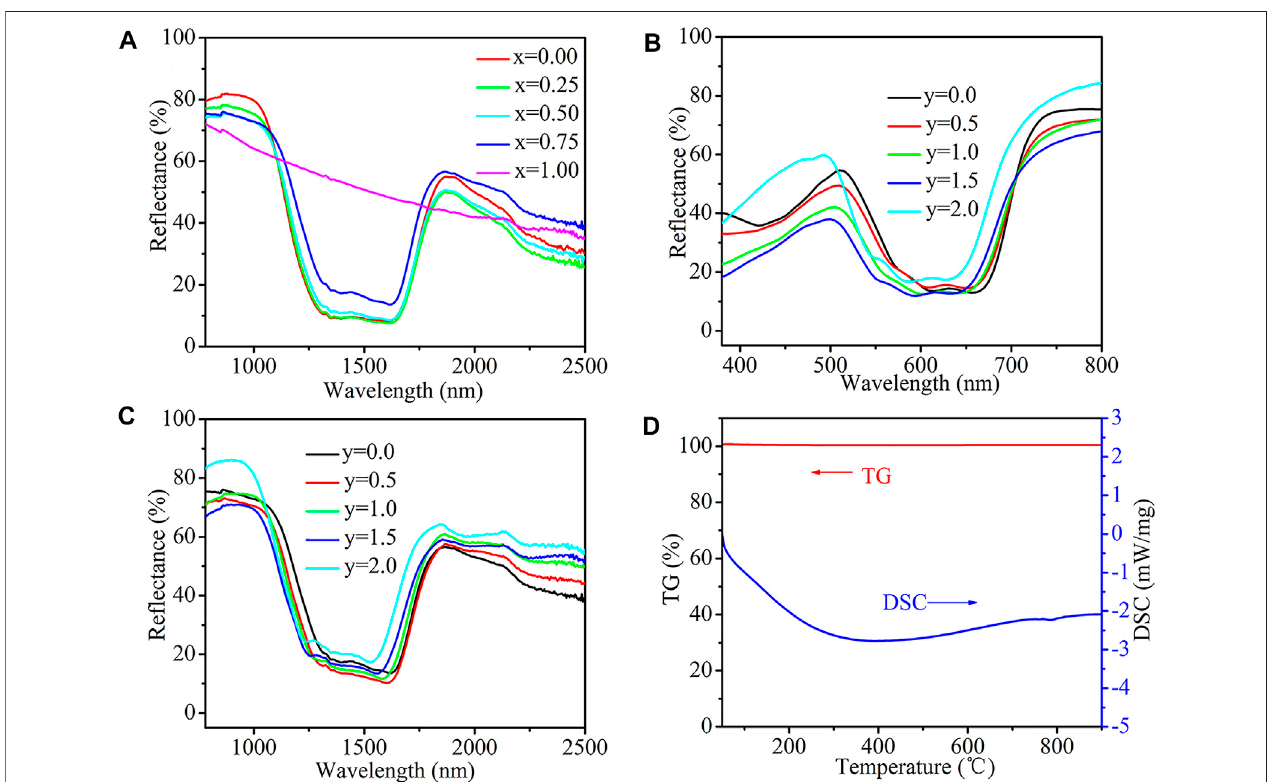
FIGURE2|(A) NIRre fl ectanceofCo 1 − x Mg x Cr 2 O 4 (x=0.00,0.25,0.50,0.75,1.00)powderedsamples (B) UV – visabsorptionspectraofCo 0.25 Mg 0.75 Cr 2 − y Al y O 4 (y = 0.0, 0.5, 1.0, 1.5, 2.0) powdered pigments (C) NIR re fl ectance of Co 0.25 Mg 0.75 Cr 2 − y Al y O 4 (y = 0.0, 0.5, 1.0, 1.5, 2.0) powdered samples (D) TG-DSC analysis of powdered Co 0.25 Mg 0.75 Al 2 O 4 pigment